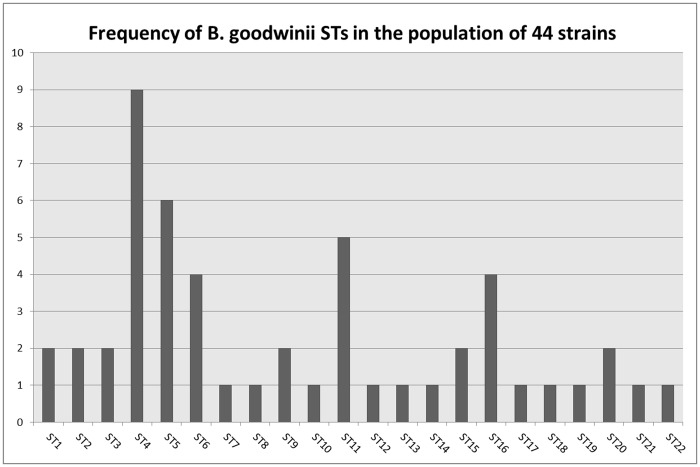
Bar chart showing frequency of STs within the studied population of 44 B. goodwinii strains.A frequency of ST occurrence is represented on the Y axis.